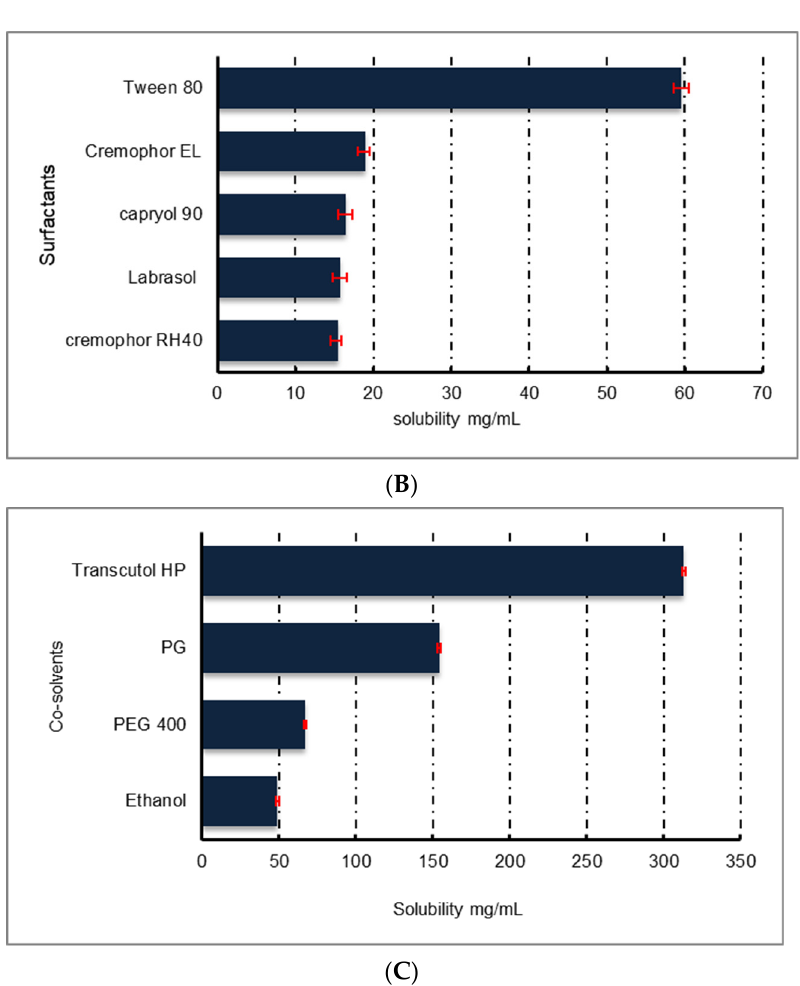
Pharmaceutics 2021 , 13 , x FOR PEER REVIEW Figure 1. Solubility of naringin in various ( A ) oils, ( B ) surfactants and ( C ) cosolvents, ( n = 3 ± SD).